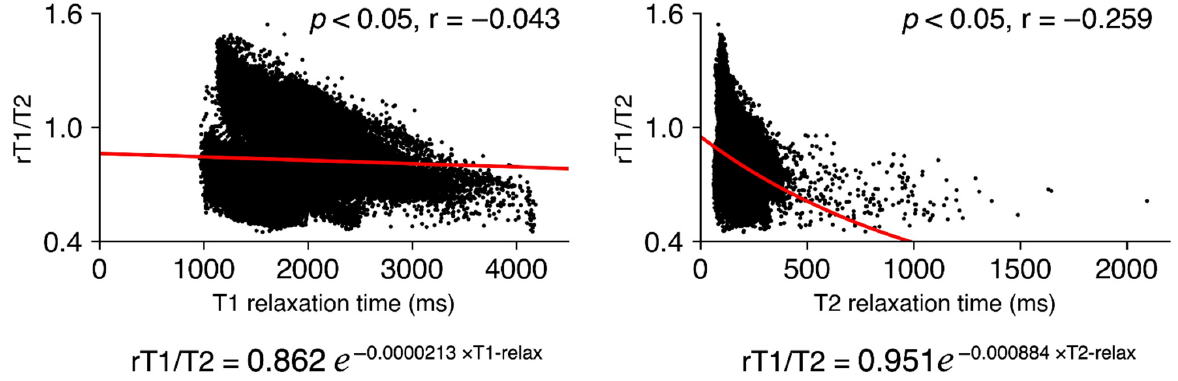
Figure 2. The logarithmic correlations between rT1/T2 and T1- and T2-relaxation times are pre- sented.